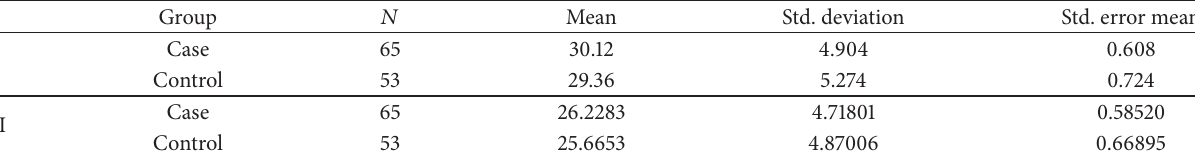
Table 1: Comparison of age and BMI in case and control groups.